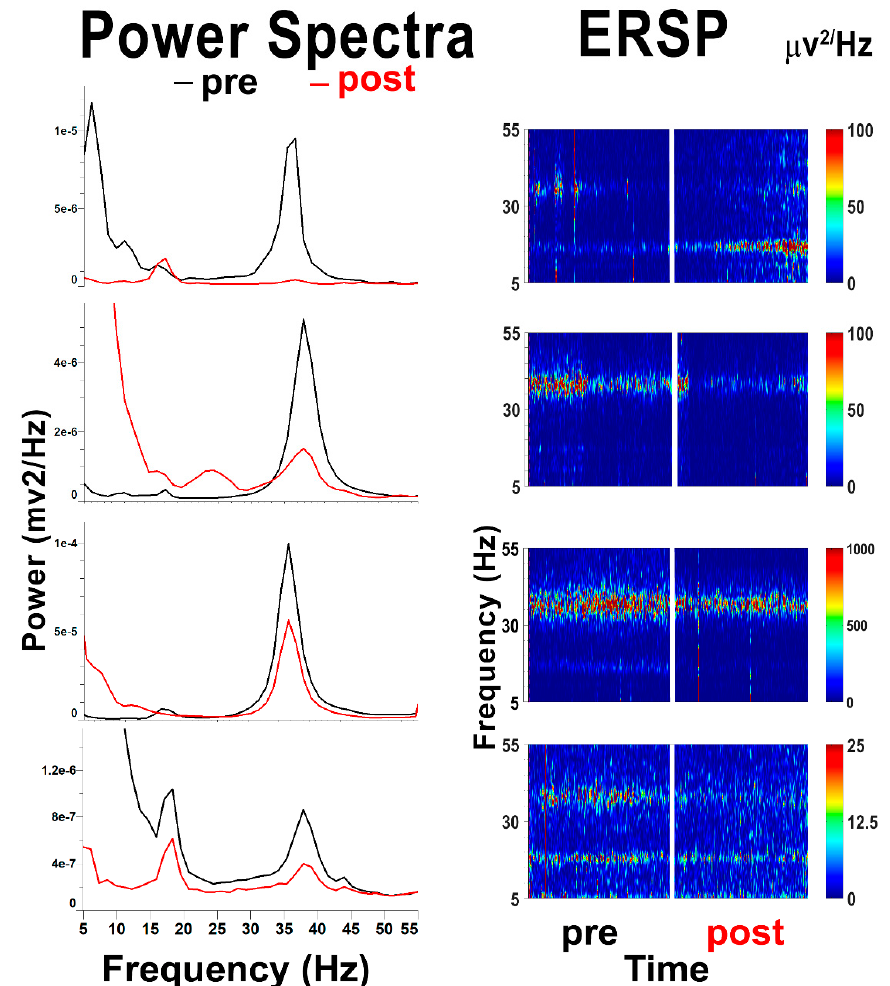
Figure 3. Population activity in the pedunculopontine nucleus (PPN) in response to TSA. The left column shows power spectra of four examples of population recordings from the PPN in brainstem slices. The slices were stimulated with carbachol (50 µ M) for 10 min, which induced an increase in gamma band activity in gamma activity (30–40 Hz range) (black lines) before (pre) the addition of TSA. TSA was applied for 10 min and carbachol stimulation continued for 10 min after (post) TSA. The power spectra after TSA (red lines) had reduced gamma activity. These power spectra were taken from the mid-point of carbachol application before and after TSA. The right column shows event- related spectral perturbations (ERSPs), which are basically running power spectra. Note that gamma activity was present in the 30–40 Hz range in each case (left ERSPs), but this activity was reduced after